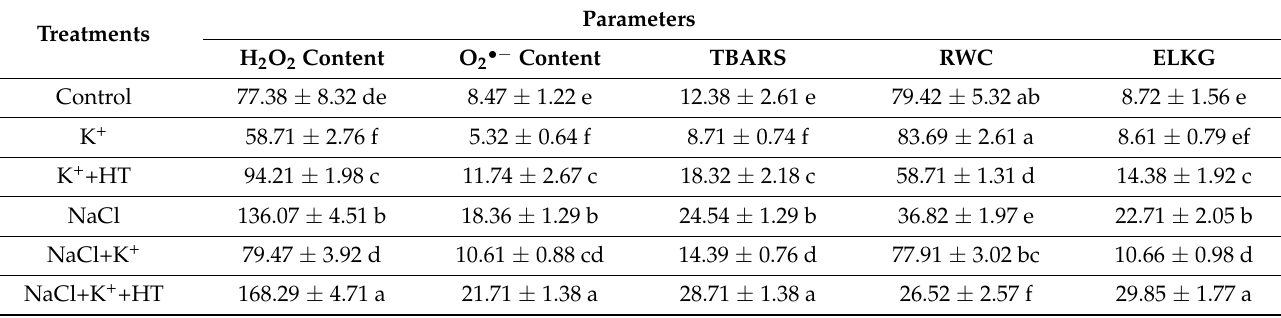
Values are means ± SE of five independent replicates. Values with different letters within a column indicate that differences were statistically significant at p < 0.05 (DMRT). Double deionized water (control), 5 mM K 2 CO 3 (K + ), 100 mM NaCl (NaCl), 1 mM hypotaurine (HT: H 2 S